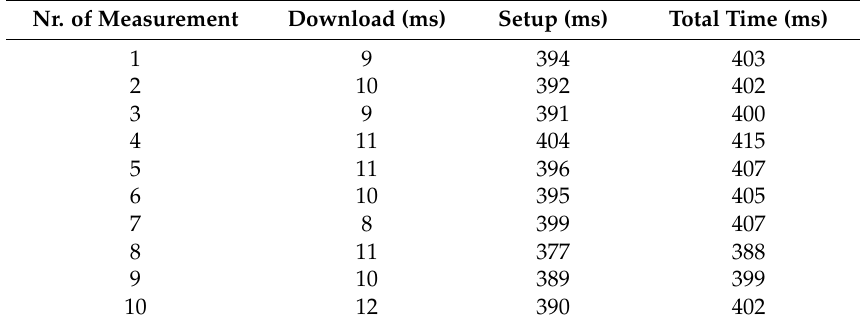
Table 1. Measurement of time needed to obtain and install updated configuration file into Cisco router. Nr. of